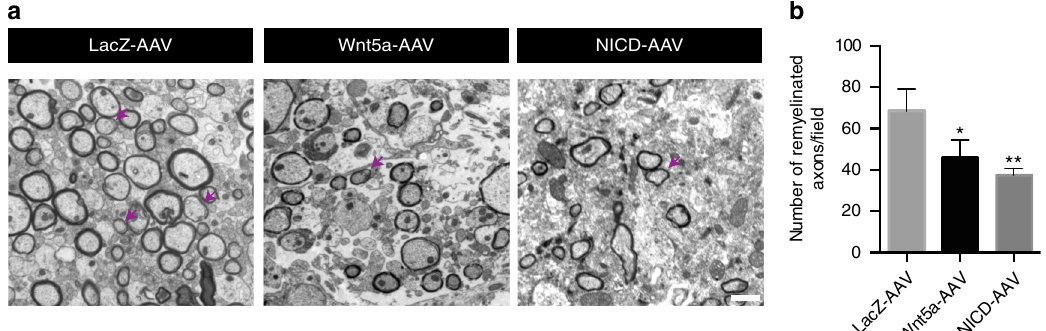
Fig. 7 Forced activation of non-canonical Wnt or Notch signaling in the SVZ delays remyelination. a Electron microscopy images from demyelinated lesions of the SCWM reveal signi fi cantly fewer remyelinated axons in mice whose SVZ were infected with Wnt5a or NICD-AAV as compared to that of LacZ-AAV at 14DPI. Arrows indicate remyelinated axons. Scale bar represents 2 µ m. b Quanti fi cation of remyelinated axons from LacZ-, Wnt5a-, and